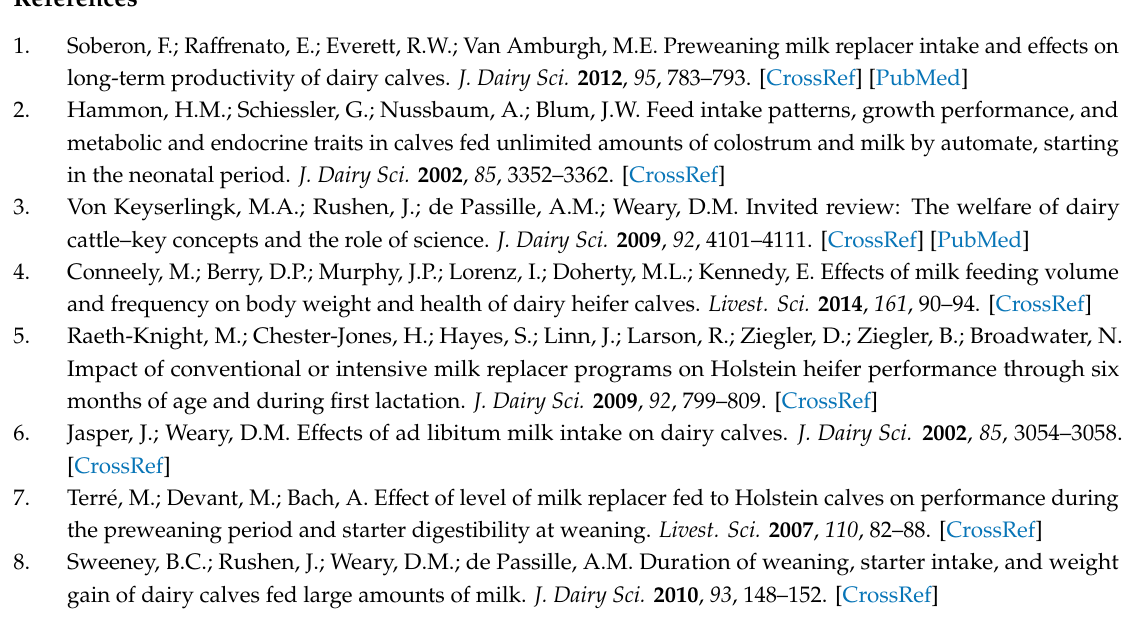
Figure S1: Diurnal lying behaviour of calves o ff ered increased (HML) or conventional (CML) levels of milk replacers over periods of milk step down and weaning. p -values represent the e ff ect of milk replacer feeding